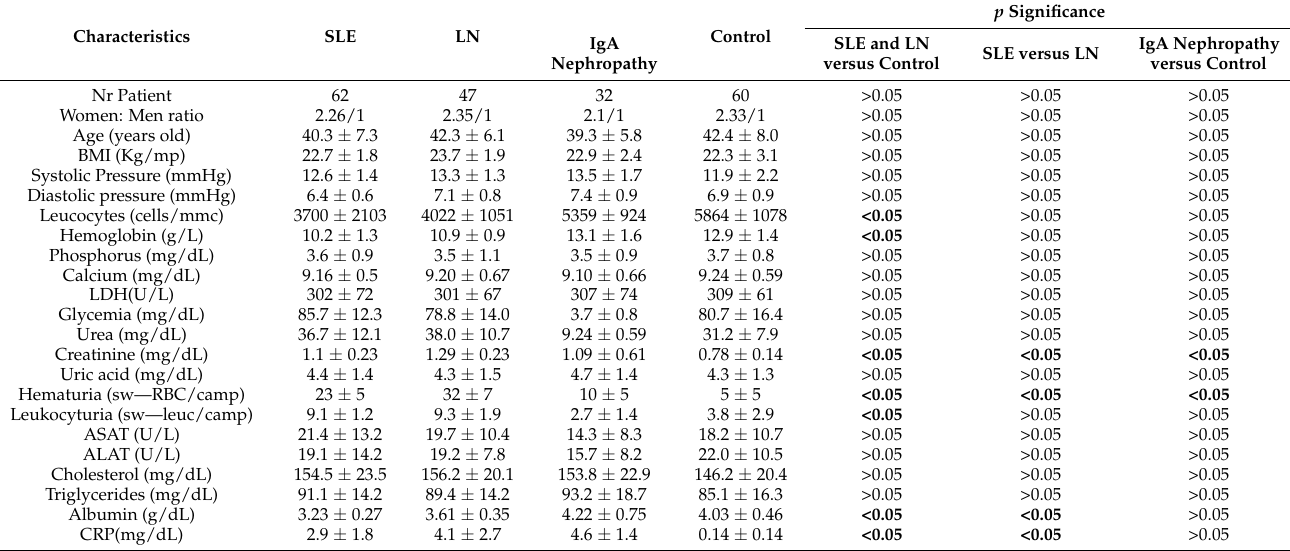
Table 1. Participants characteristics in the studied